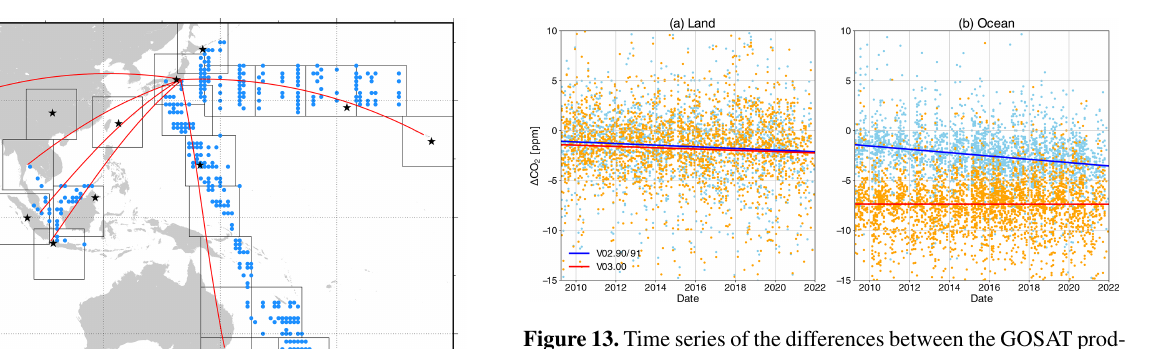
Figure 13. Time series of the differences between the GOSAT prod- ucts and in situ measurements (GOSAT minus in situ measure- ments) over land (a) and the ocean (b) . The regression lines are plotted as red and blue lines.